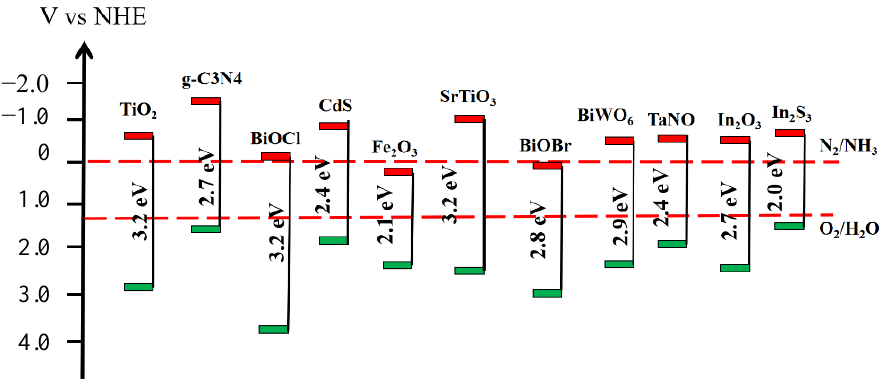
Figure 3. Band− edge positions for conventional semiconductors (vs. NHE at pH = 0). Figure 3. Band–edge positions for conventional semiconductors (vs. NHE at pH =